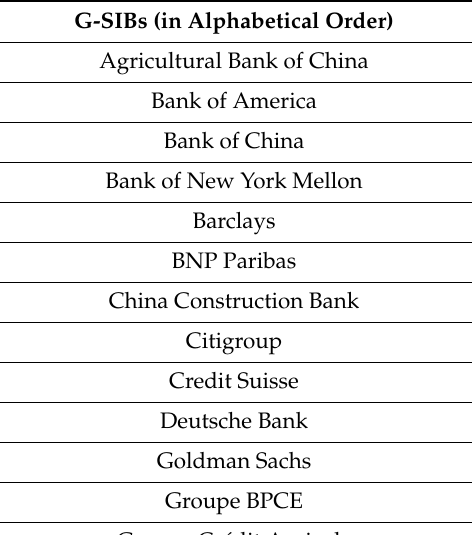
Table 2. List of G-SIBs (Source: FSB 2019). G-SIBs (in Alphabetical